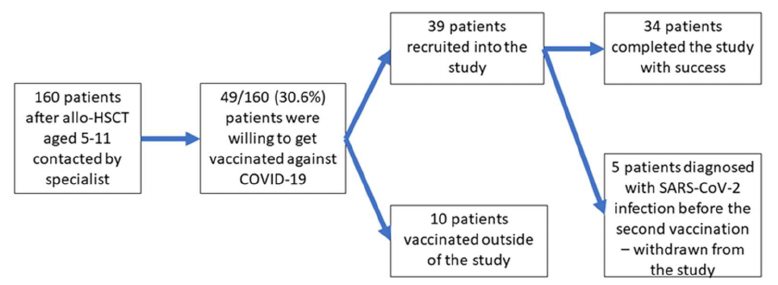
Figure 2. Flowchart of the study.